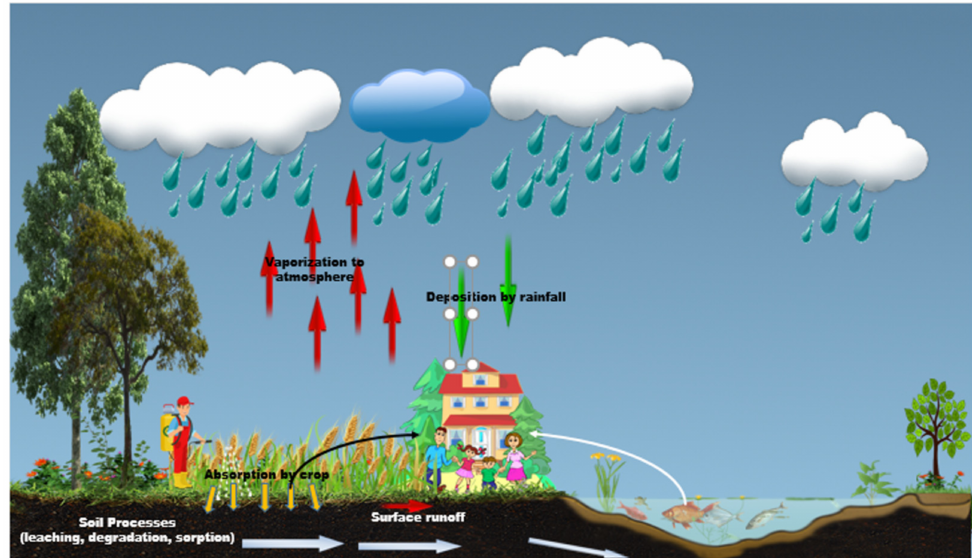
Figure 1. Pesticide behavior in the natural environment in a crop field (by authors).